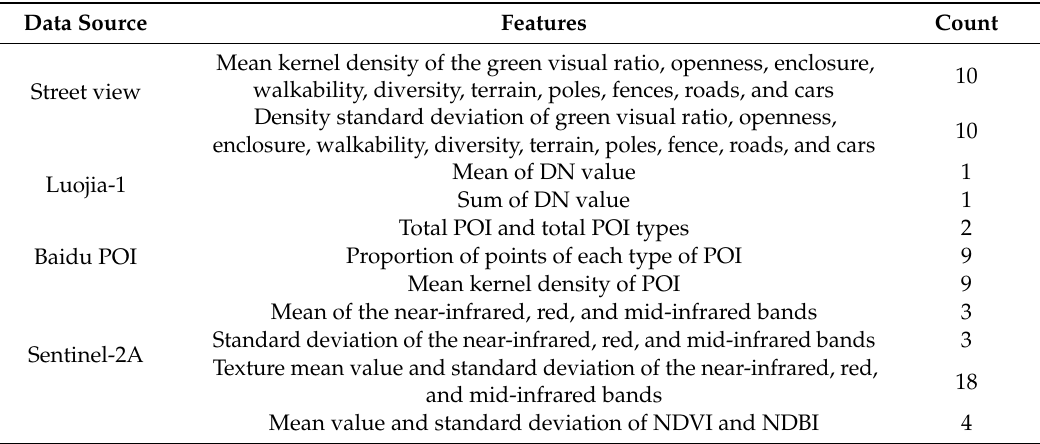
Table 2. Summary of the features describing urban